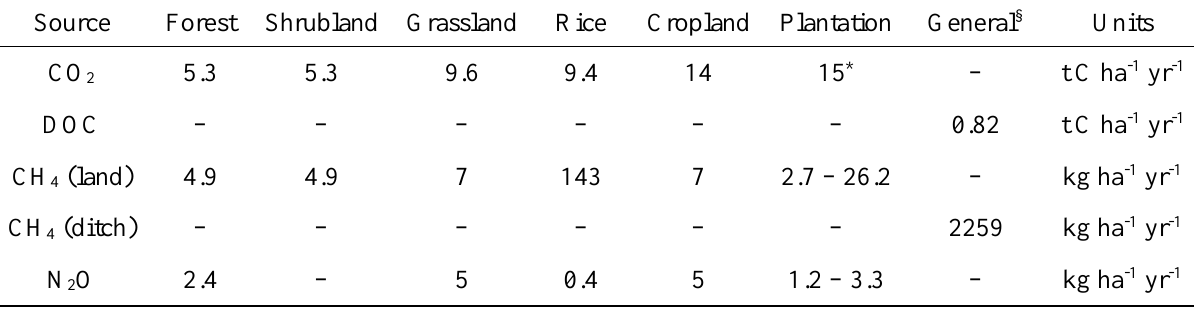
Figure 2. Relationship between peat carbon dioxide (CO 2 ) loss and peat water table level in (short-term) fluxes and in annual emission estimates. Total soil flux (g CO 2 m -2 h -1 ) for agroforestry and primary, secondary and selectively logged forests from Couwenberg et al . (2010), modelled annual heterotrophic emission (t CO 2 ha -1 y -1 ) for Acacia crassicarpa plantation (Jauhiainen et al . 2012a, Husnain et al . 2014) and rubber plantation (Husnain et al . 2014), CO 2e emissions modelled from peat subsidence for Acacia plantation and drainage-affected forest (Hooijer et al . 2012), and modelled total annual CO 2 emissions for secondary forest (Husnain et al . 2014). Table 1. Carbon and greenhouse gas emission factors for drained tropical peatlands (IPCC 2014).